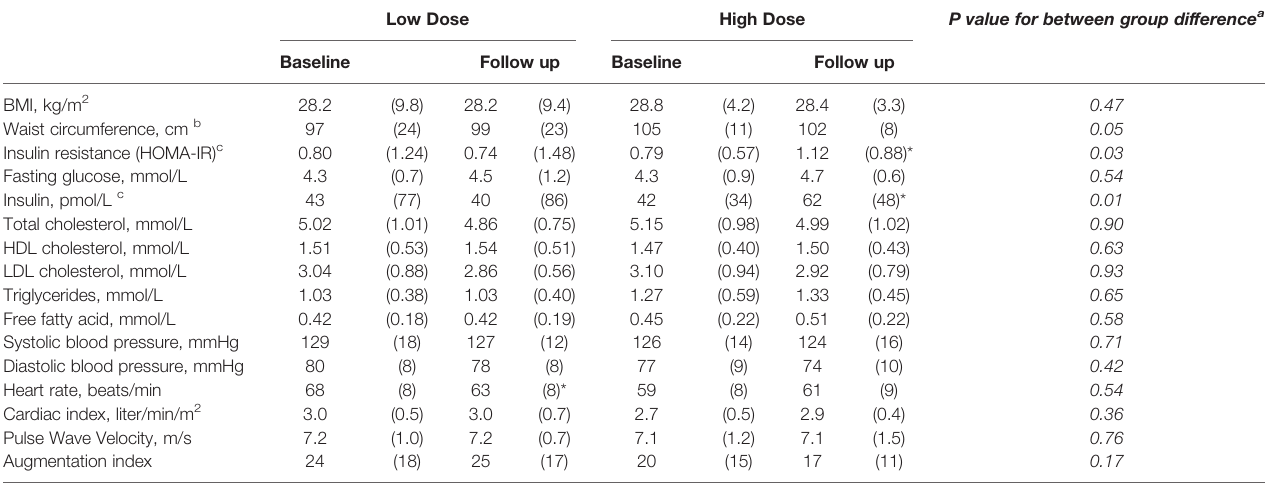
TABLE 2 | The effect of increasing or decreasing IGF-1 level on measurements of body composition, insulin resistance, and macrovascular hemodynamics and vascular stiffness. Low Dose High Dose P value for between group difference a Baseline Follow up Baseline Follow up